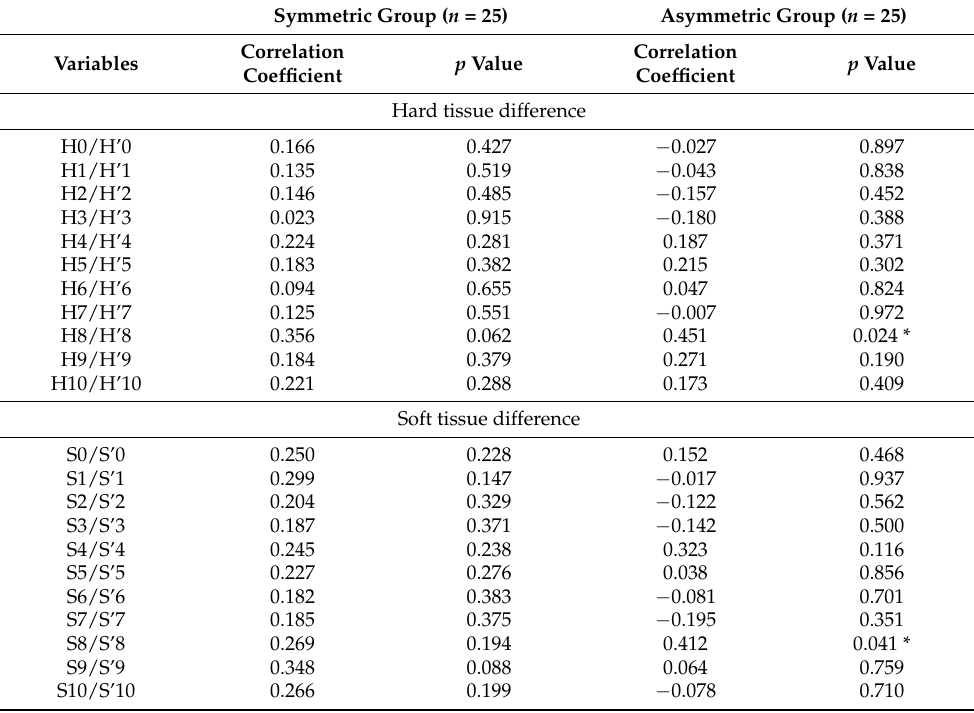
Table 4. Correlation between menton deviation and bilateral differences in the symmetric and asymmetric